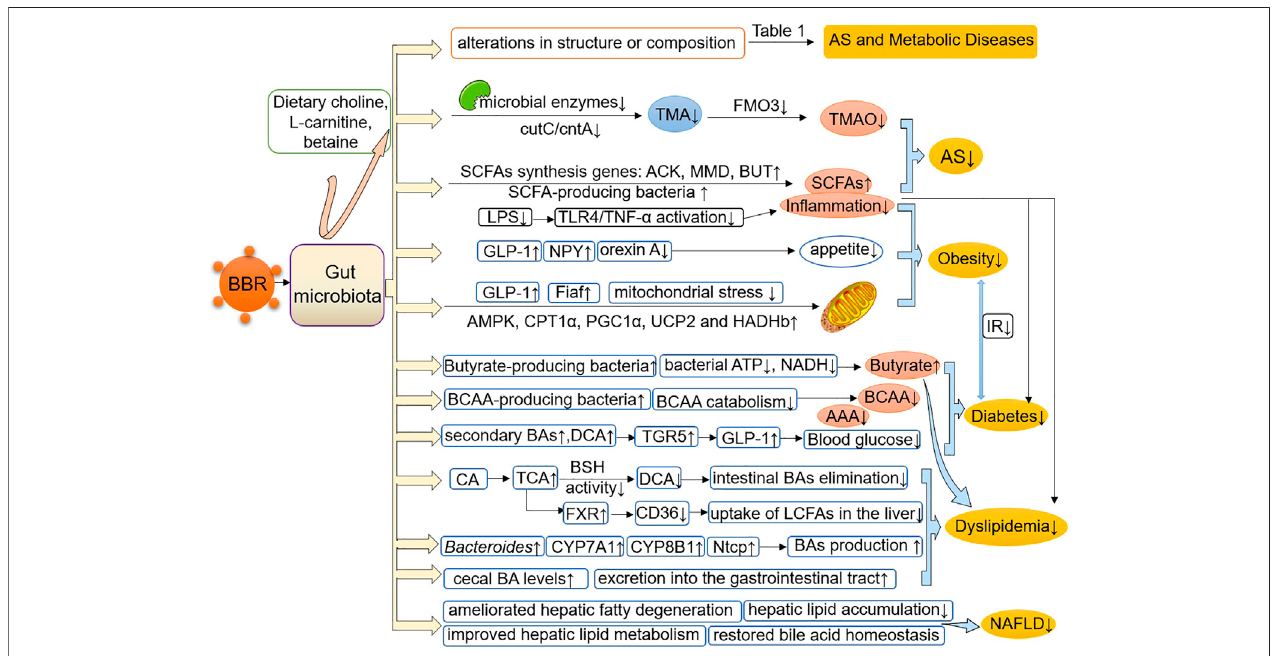
FIGURE 2 | BBR improves AS and metabolic diseases by modulating the gut microbiota and its-dependent metabolites. BBR reverses or induces structural and compositional alterations in the gut microbiota and regulates gut microbe-dependent metabolites, including TMAO, SCFAs, BAs, BCAAs and AAAs, as well as related downstream pathways, thereby improving the body ’ s in fl ammatorystate, glucose and lipid metabolism and energy homeostasis, and playing abene fi cial role in AS and metabolic diseases. AS, atherosclerosis; TMA, trimethylamine; TMAO, trimethylamine N-oxide; ACK, acetate kinase; MMD, methylmalonyl-CoA decarboxylase; BUT, butyryl-CoA: acetate-CoA transferase; SCFAs, short-chain fatty acids; LPS, lipopolysaccharide; TNF- α , tumor necrosis factor- α ; GLP-1, glucagon-like peptide-1; NPY, neuropeptide Y; Fiaf, fasting-induced adipose factor; AMPK, AMP-activated protein kinase; CPT1 α , carnitine palmitoyltransferase 1 α ; PGC1 α , peroxisome proliferator-activated receptor- γ coactivator 1- α ; HADHb, hydroxyacyl-CoA dehydrogenase trifunctional multienzyme complex subunit β ; UCP2, uncoupling protein 2;